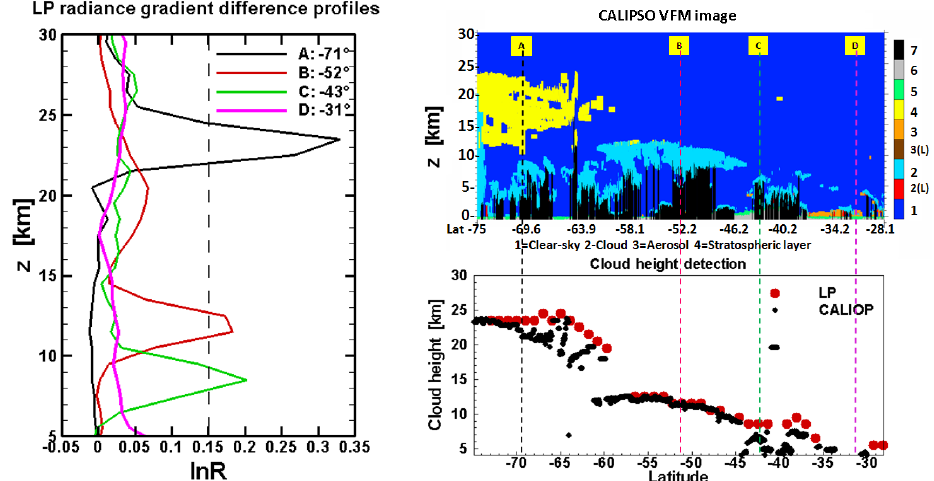
Figure 2. Radiance gradient and cloud detection results for four Southern Hemisphere events from a single orbit on 16 August 2012, using OMPS/LP measurements and CALIPSO vertical feature mask (VFM) daytime data. Left panel: vertical profiles of the LP radiance gradient lnR for each event. The dashed black line represents the cloud detection threshold, which identifies clouds in events A, B, and C. Top right panel: CALIPSO VFM image for the same orbit. Yellow features indicate polar stratospheric clouds (PSCs), and light blue patches represent clouds. Bottom right panel: cloud height values detected by the LP algorithm (red dots) and from CALIPSO VFM data (black dots) in the same orbit. The four colored dotted lines in the right panel indicate the four events labeled as A, B, C, and